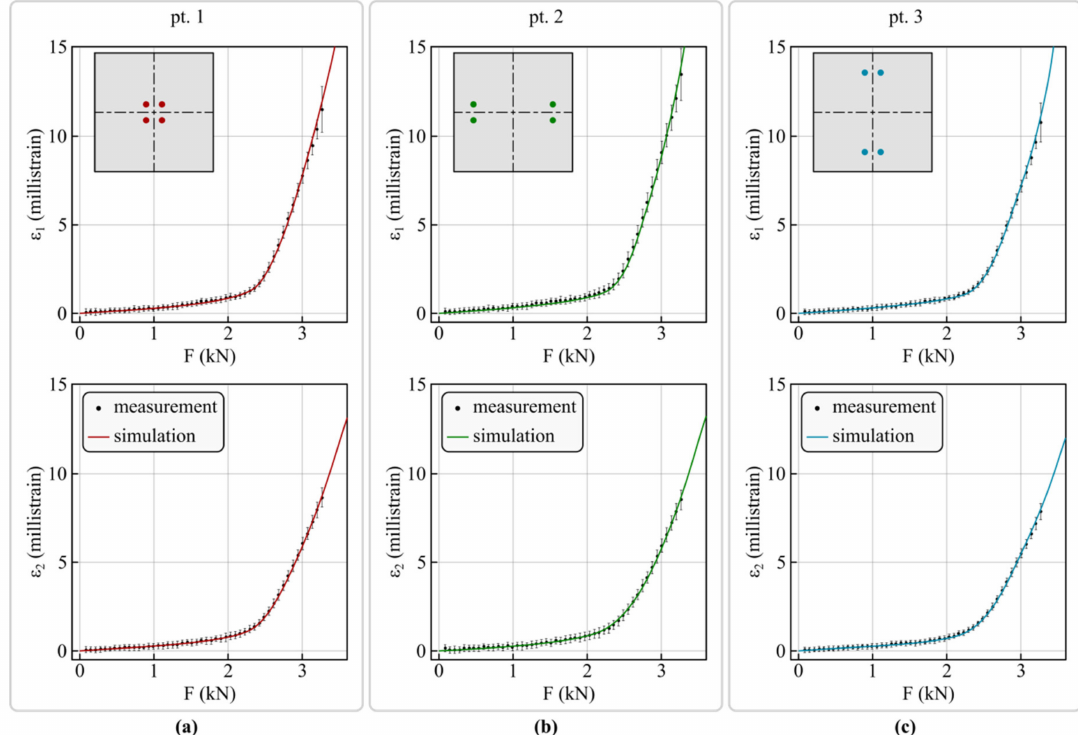
Figure 6. Comparison of simulated and measured responses of the heterogeneous specimen test: ( a ) max. / min. strain–force response at the close-to-centre points (pt. 1), ( b ) max. / min. strain–force response at the horizontal far-from-centre points (pt. 2), ( c ) max. / min. strain–force response at the vertical far-from-centre points (pt.